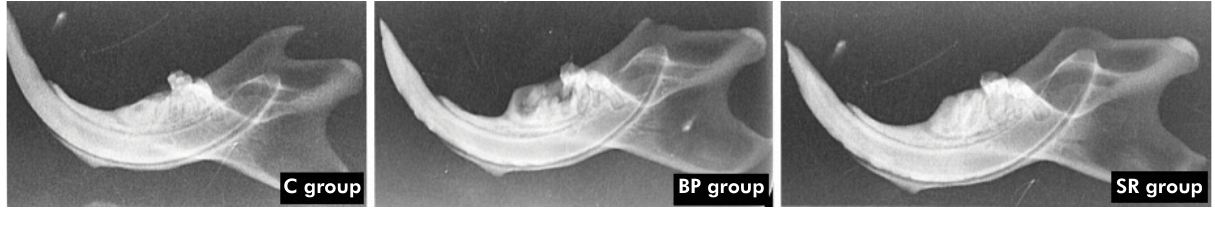
Figure 2. Radiographical aspect of control, strontium ranelate (SR), and zoledronic acid (BP) groups. Observe the presence of bone sequestration after extraction of the first molar in the BP group (white arrow).